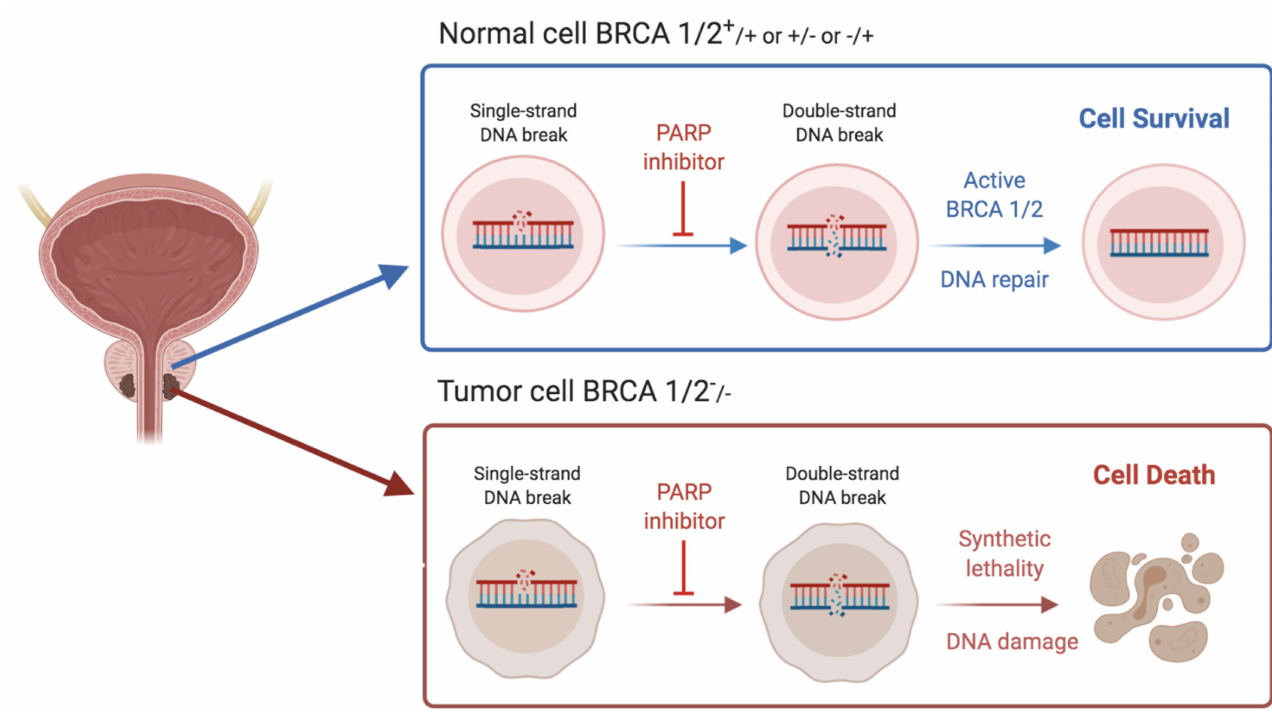
Figure 3. Figure schematically representing the mechanisms of action of PARP inhibitors treatment for patients with BRCA-mutant prostate cancer. BRCA1 and BRCA2 genes have been suggested to encode proteins of pivotal importance to DNA homologous recombination repair